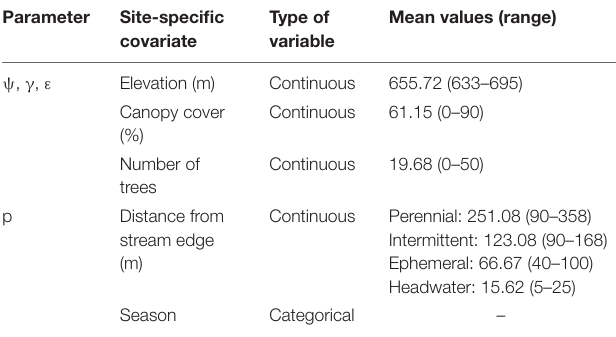
TABLE 4 | Final list of habitat covariates used in the occupancy models.